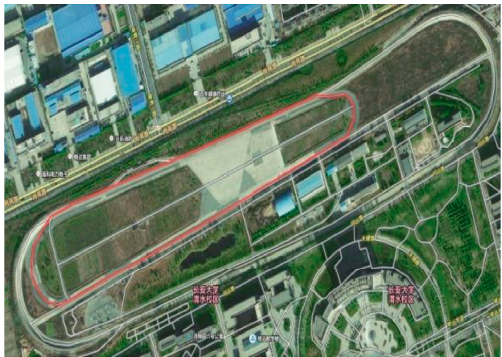
Figure 9: Satellite image of the test track.